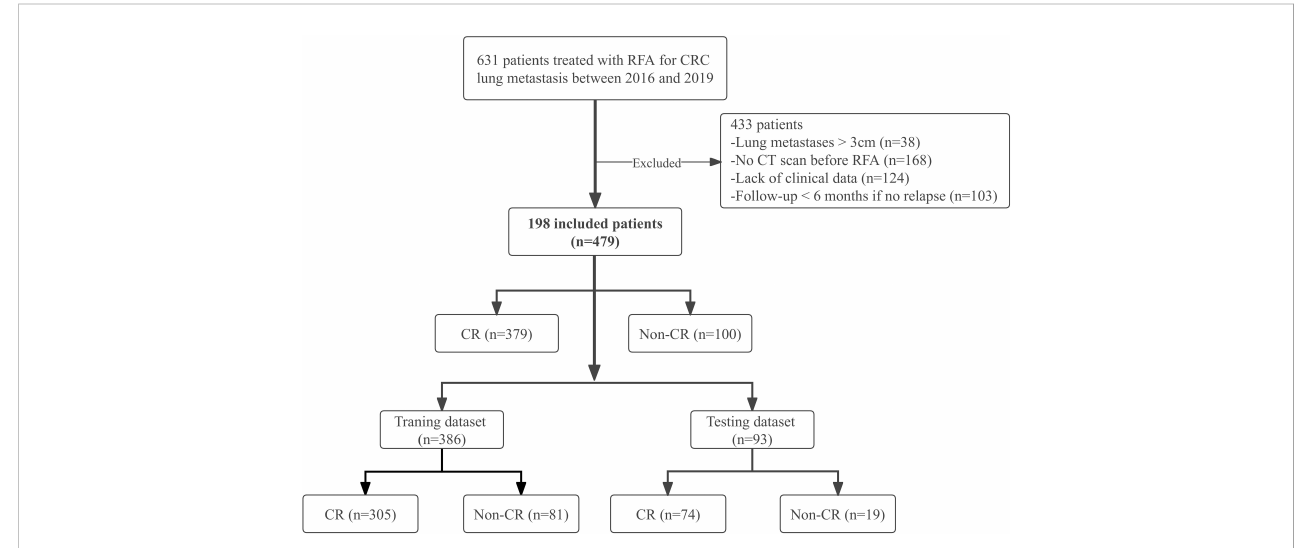
FIGURE 1 Study fl ow chart. CRC, colorectal cancer; CR, complete response; Non-CR, Non-complete